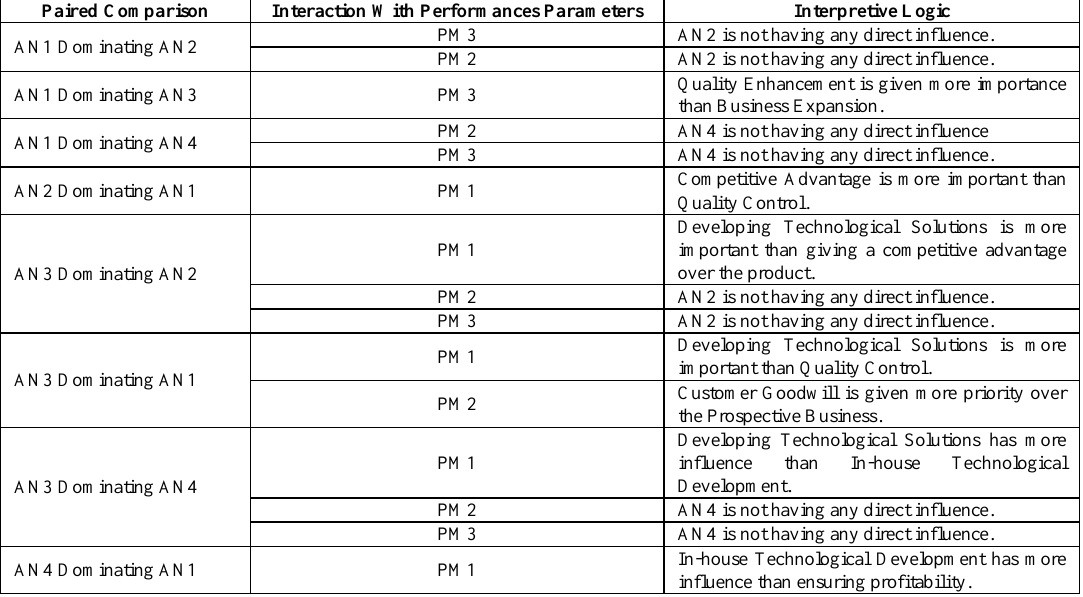
Table 15. Knowledge base ranking of actions and performance parameters.